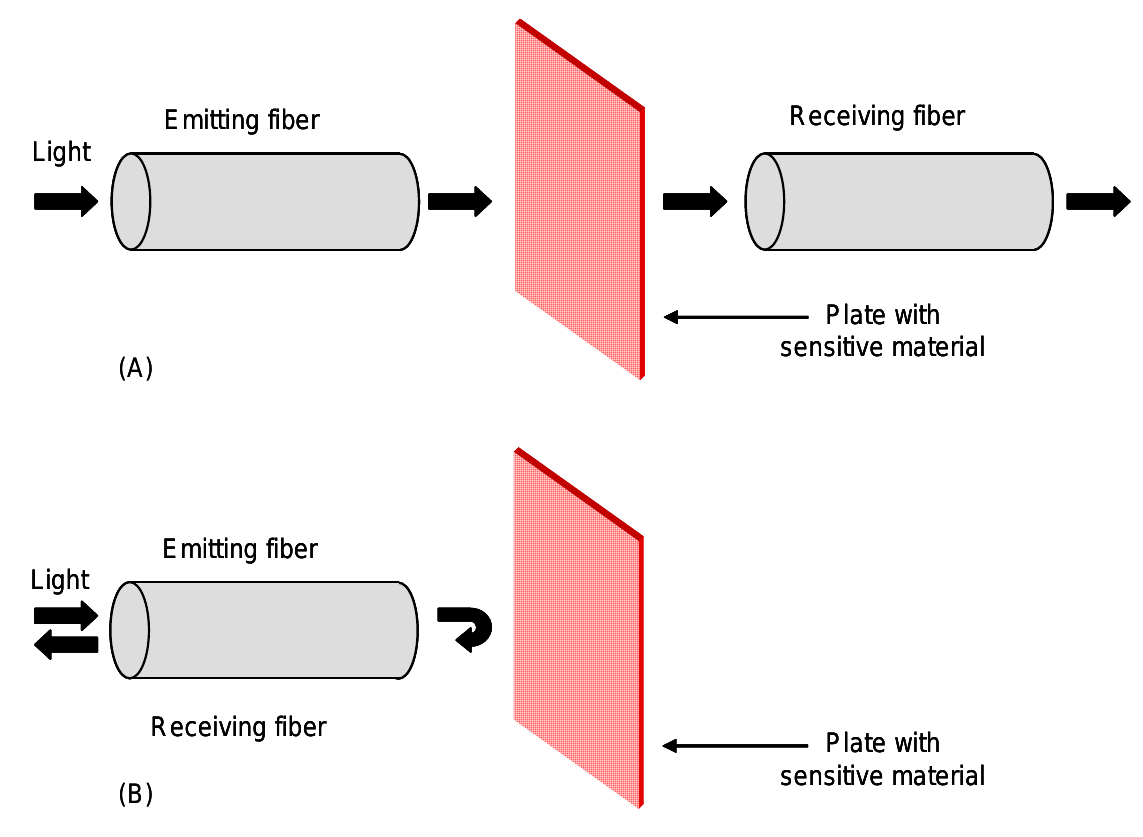
Figure 5. Extrinsic sensors where Light interacts with a chemical dye: in (A), the optical signal passes through the dye, while in (B) the reflected light from the plate is coupled back into the